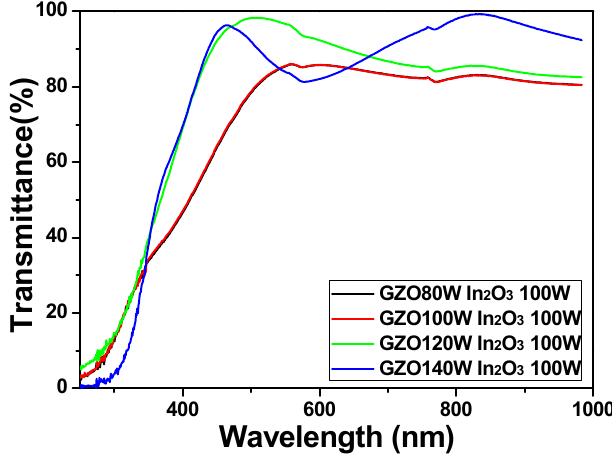
Figure 6. Transmittance spectrum of IGZO thin films as a function of deposition power of GZO ceramic